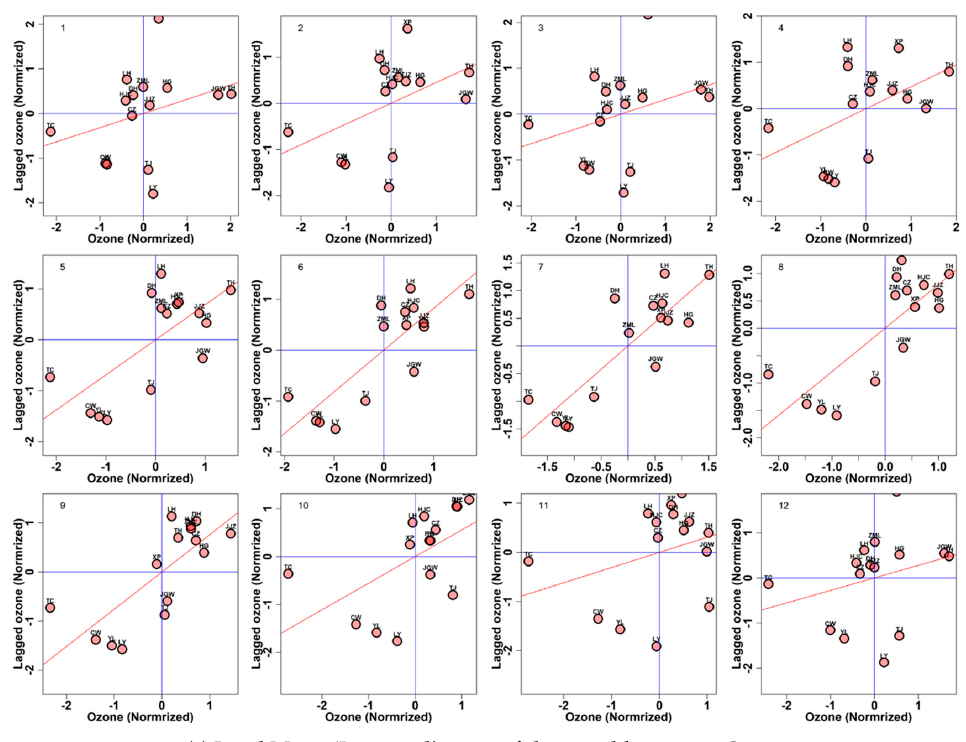
Figure 5. Local Moran’I variations in different time scales ( a – c ) in PRD. a, b and c are local Moran’I of the averages through 2007 to 2018, each year and each month respectively. The horizontal and vertical pink lines specified the 0 location of x and y axises and the y Indicates the normalized ozone